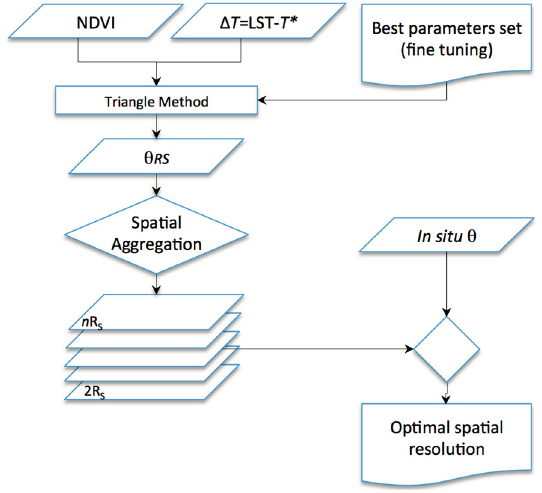
Figure 3. Flow diagram for the optimal spatial resolution determination.